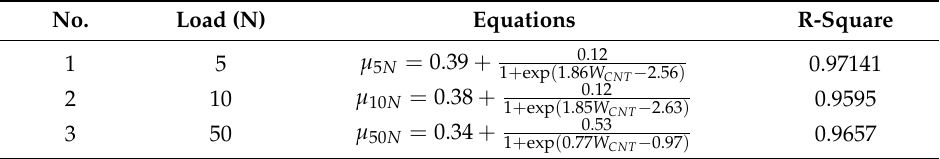
Figure 12. Wear mass loss variation as a function of CNT content in the as-extruded AZ31 matrix at different normal loads. Table 6. Regression equations of the mass loss versus the content of CNTs (wt. %).